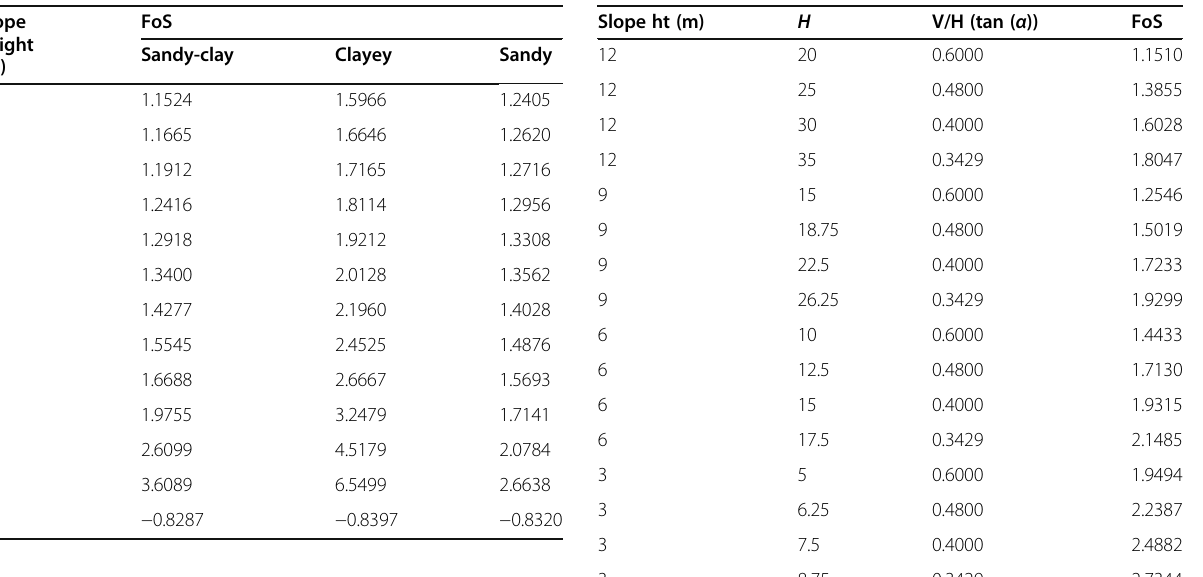
Table 6 Slope angle, height, and factor of safety